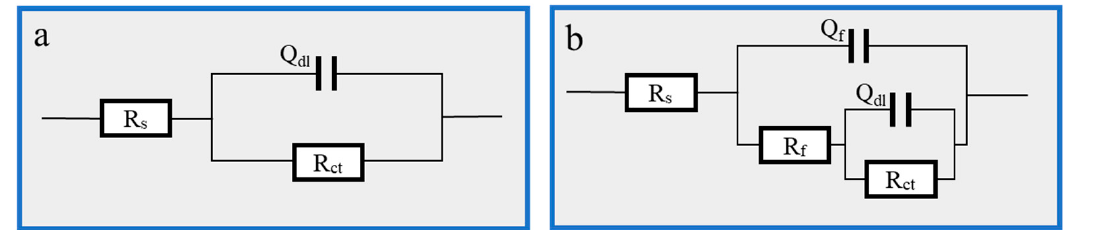
Figure 3. EIS fi tt ing equivalent circuit: ( a ) 1 M HCl solution; ( b ) Thy-1 corrosion inhibitor is added.